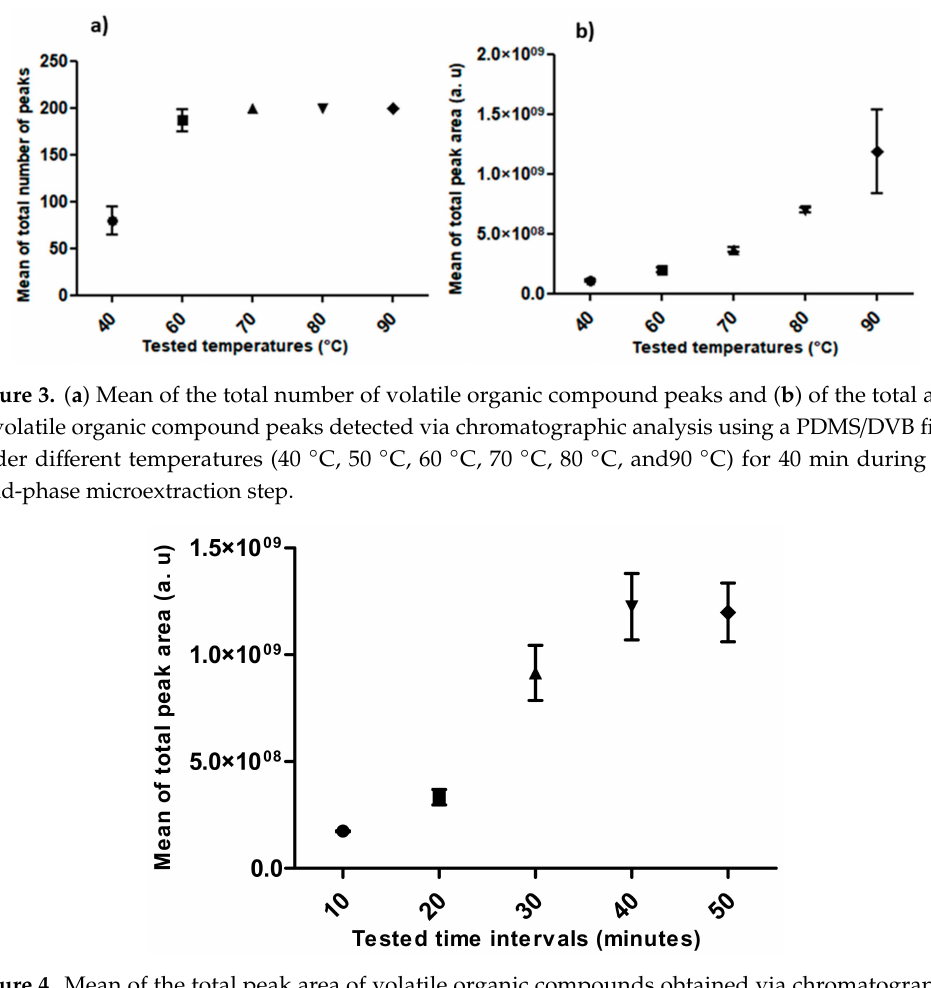
Figure 4. Mean of the total peak area of volatile organic compounds obtained via chromatographic analysis using a PDMS / DVB fiber at di ff erent time intervals (10, 20, 30, 40, and50 min) in the microextraction